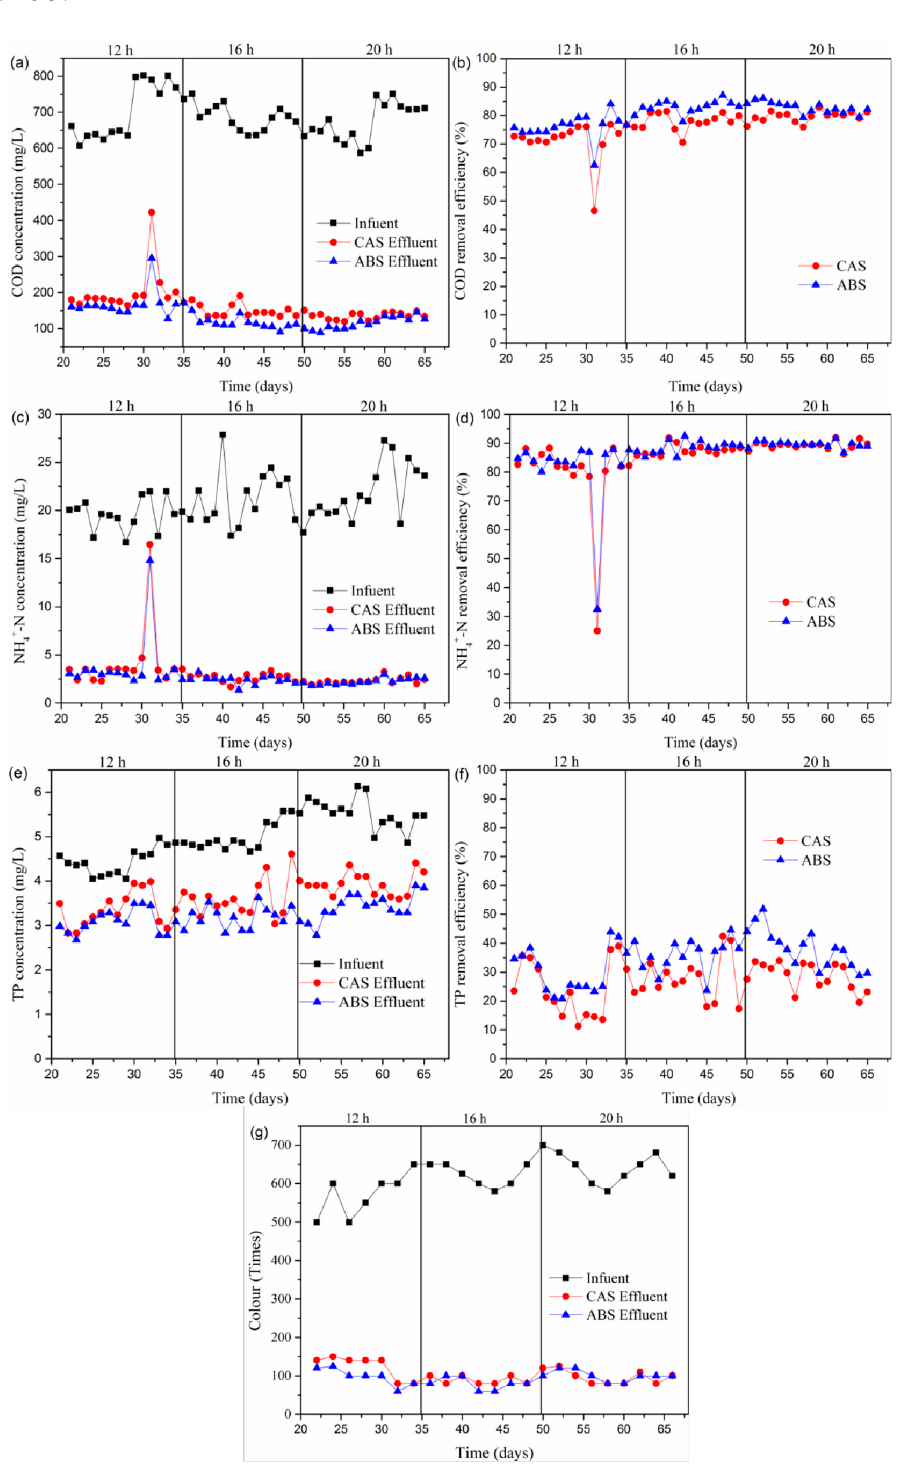
Figure 6. Removal performance of COD ( a , b ), NH 4 + -N ( c , d ), TP ( e , f ) and colour (times) ( g ) in the CAS system and ABS system under different HRTs: 12 h, 16 h and 20 h, and the same aeration: 0.4 – 0.5 L/min.